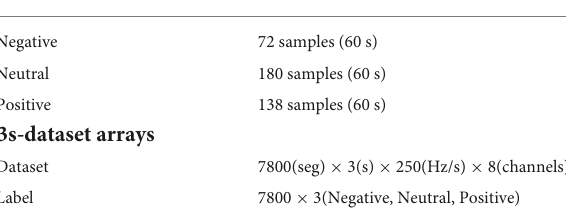
TABLE 4 The emotion classification of OCER and the data arrays. Emotion classification